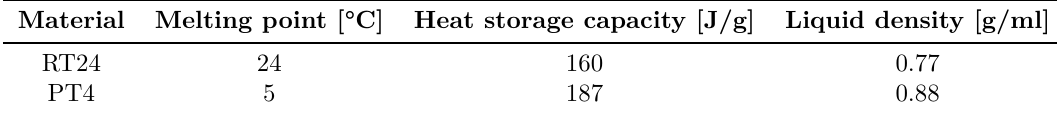
Table 1. Pure PCM thermal